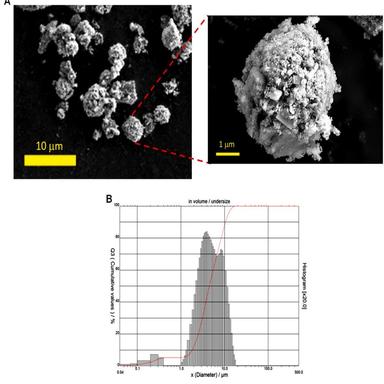
(A) SEM images of nanoporous HA microparticles at different magnification scales. (B) Particle size distribution of nanoporous HA microparticles by laser diffraction technique.